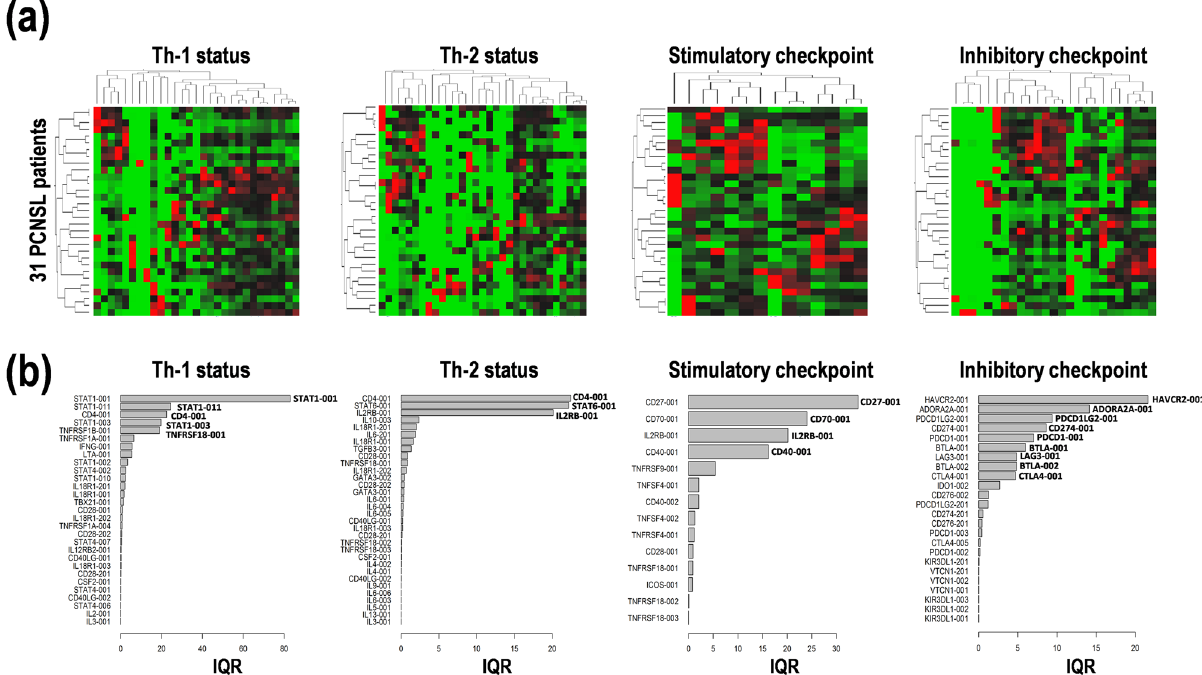
Figure 1. Expression patterns of transcript variants of the genes related to T helper cells type 1/2 (Th-1/Th-2) and immune checkpoint in primary central nervous system lymphoma (PCNSL). ( a ) Hierarchical clustering of relative expression among samples and ( b ) interquartile range (IQR) of the transcript variants of genes related to Th-1, Th-2, stimulatory checkpoint, and inhibitory checkpoint in 31 PCNSL patients. High and low expression is indicated by red and green, respectively, in heat